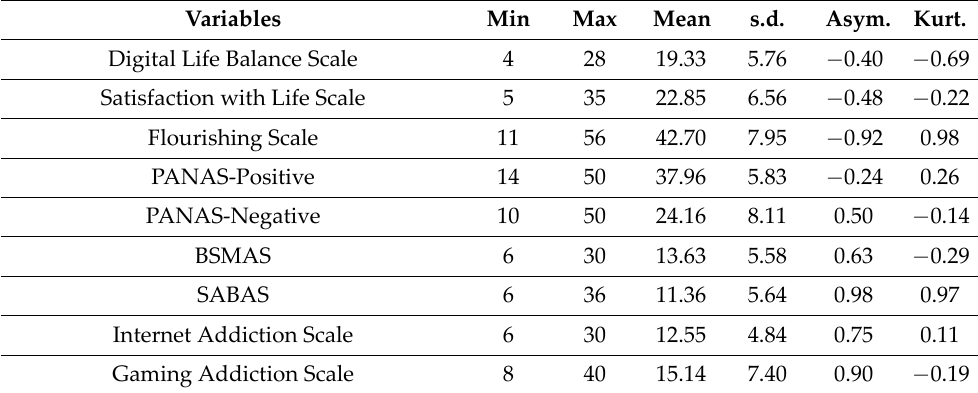
Table 2. Descriptive statistics of the variables collected in study 2.